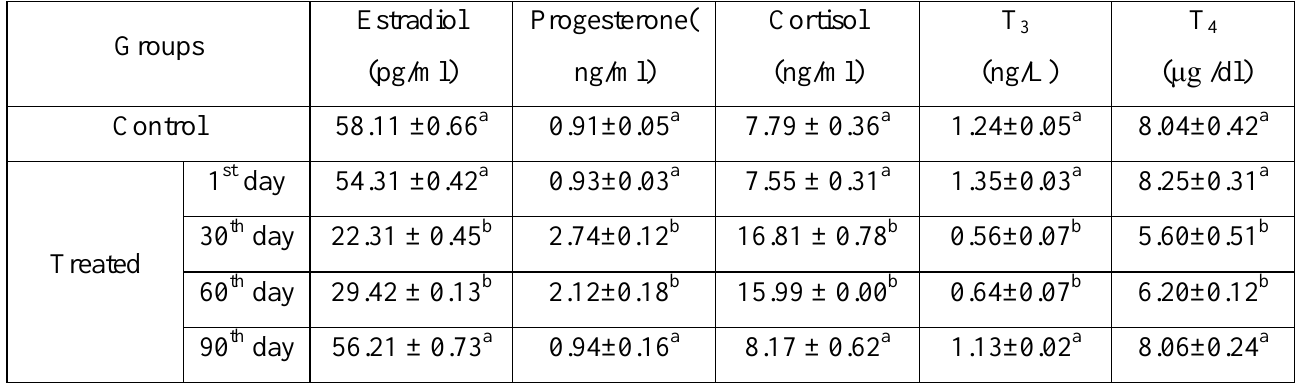
Table 4: IVM's effects on serum reproductive hormones in ewes